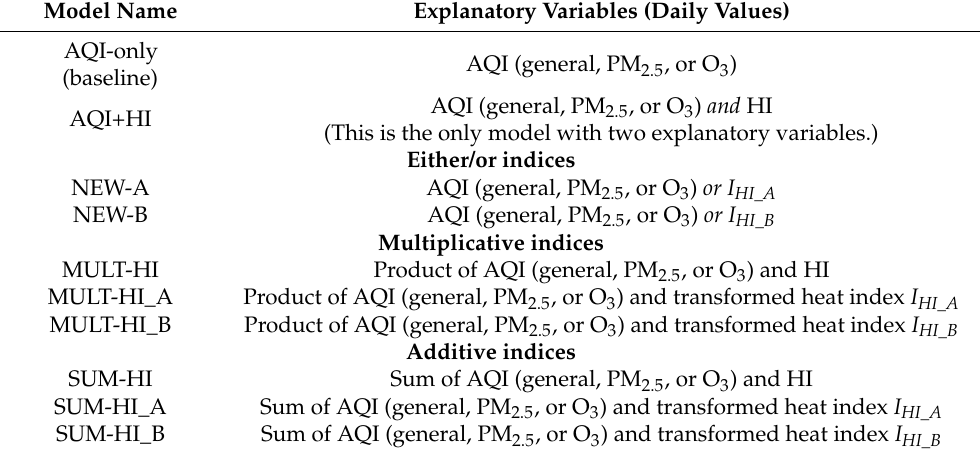
Table 1. The characteristics of the Poisson regression models utilized. Model